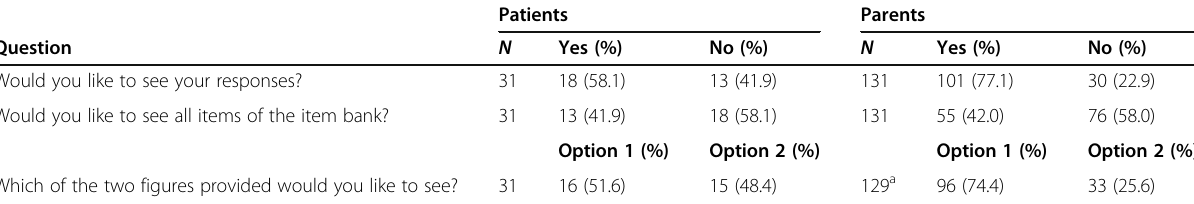
Table 3 Questionnaire results for patients and parents